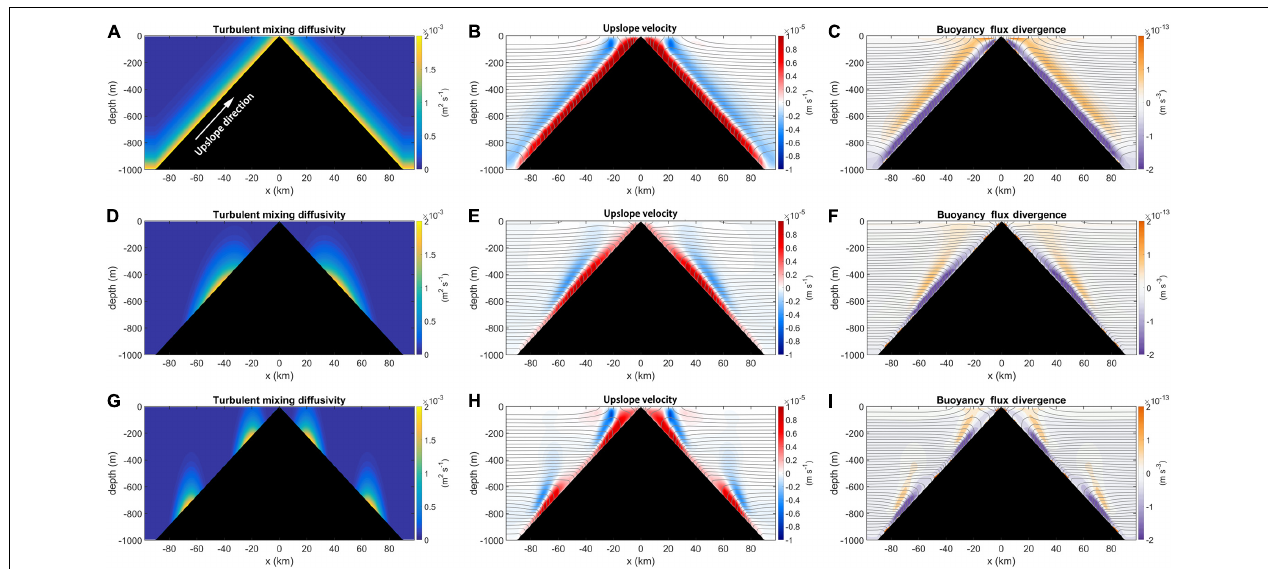
FIGURE 8 | (A,D,G) Spatial distributions of the turbulent diffusivity applied in the model experiments corresponding to Exp1, Exp2, and Exp3, respectively. (B,E,H) Spatial distributions of the upslope velocity of Exp1, Exp2, and Exp3, respectively. (C,F,I) Spatial distributions of the turbulent buoyancy flux resulting from the bottom-intensified turbulent mixing around the conic seamount corresponding to Exp1, Exp2, and Exp3, respectively. The upslope direction is indicated by the white arrow in panel (A)